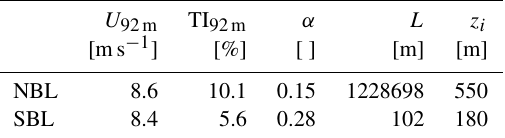
(cid:16) z (cid:17) α 2 z 1